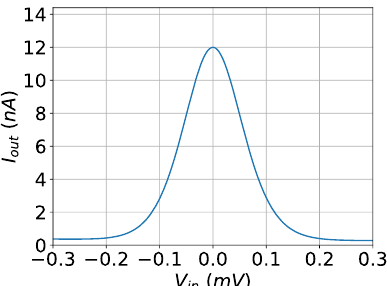
Figure 3. The output of the bump circuit for I bias = 12 nA, V r = 0 V, and V c = 0